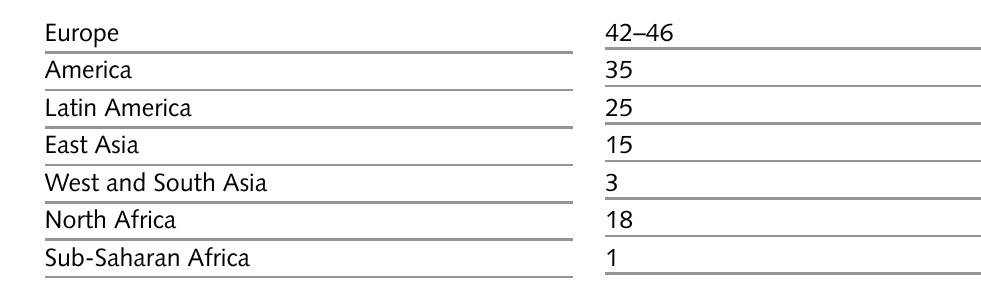
Source: Peter Alberti, personal communication,